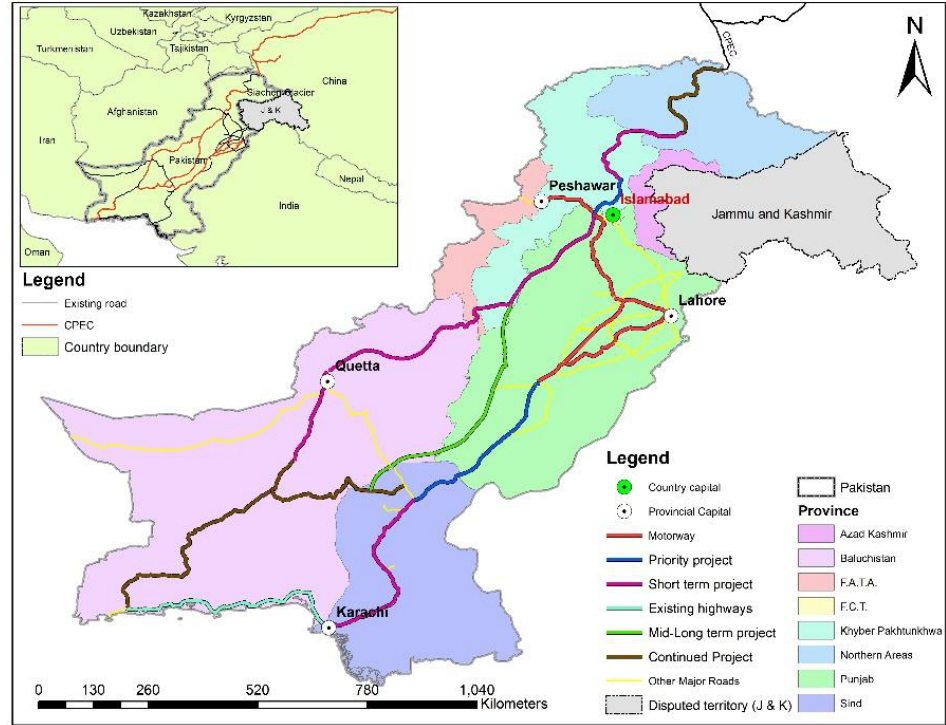
Figure A2. Highway network of CPEC. Source: Based on information from [3].